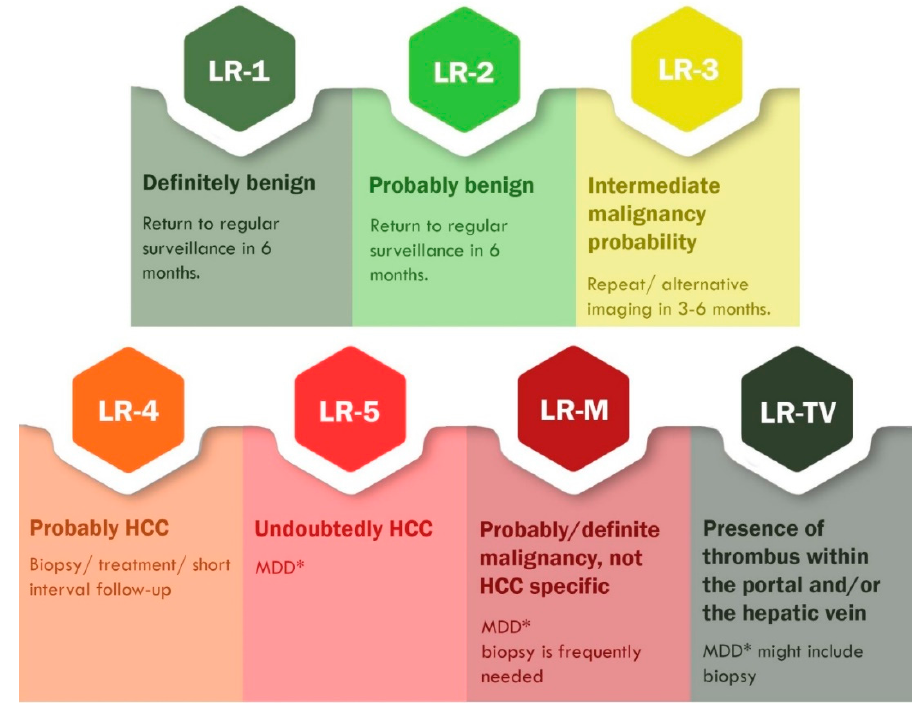
Figure 4. CEUS LI-RADS classification and management of FLLs according to the American College of Radiology [59,111]. This table includes only CEUS pure blood pool agents (SonoVue, Luminity). * MDD: multidisciplinary discussion; #MDD should be considered, since a recent prospective study found that 60% of CEUS LR-3 observations were HCCs